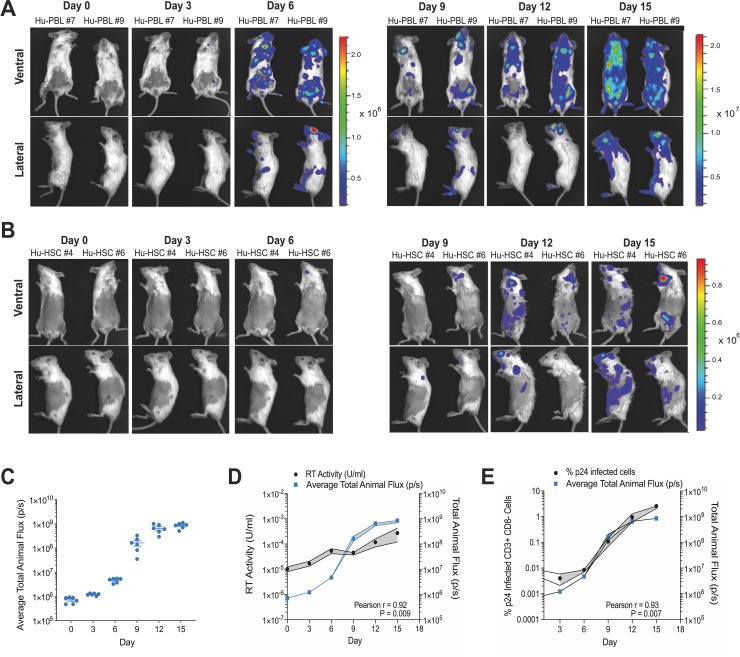
Non-invasive bioluminescent imaging of longitudinal Q23.BG505.Nluc infection in humanized mice.(A) Longitudinal imaging of Hu-PBL mice (n = 6) infected intraperitonially (i.p.) with 1 x 107 infectious units (IUs) of BG505.Nluc* reporter virus. Data representative of six independently infected animals. (B) Longitudinal imaging of productive HIV-1 infection in Hu-HSC mice (n = 2) infected i.p. with 1 x 106 IUs of BG505.Nluc* T/F reporter virus. (C) Quantification of bioluminescent signal measured over a 15-day period in BG505.Nluc* infected Hu-PBL mice. Average total animal flux was calculated by taking the mean of the total animal flux measured from both the ventral and lateral imaging orientations, excluding the cranial region to avoid signal artifacts arising from the Nano-glo substrate injection site. Data displayed as the mean +/- SEM from six independent experiments. (D, E) Correlative analysis of average total animal flux with the increase of peripheral HIV-1 infected cells (p24+CD3+CD8- cells) measured by flow cytometry (D) and plasma reserve transcriptase activity (RT U) in the infected Hu-PBL mice in (C) measured by the reserve transcriptase SG-PERT activity qPCR assay (E). Upper and lower bounds of the SEM is displayed as gray shaded regions above and below the mean value at each day measured. Pearson correlations was calculated from the average values of peripheral HIV-1 infected cells and average total animal flux and plasma reverse transcriptase activity and average total animal flux.